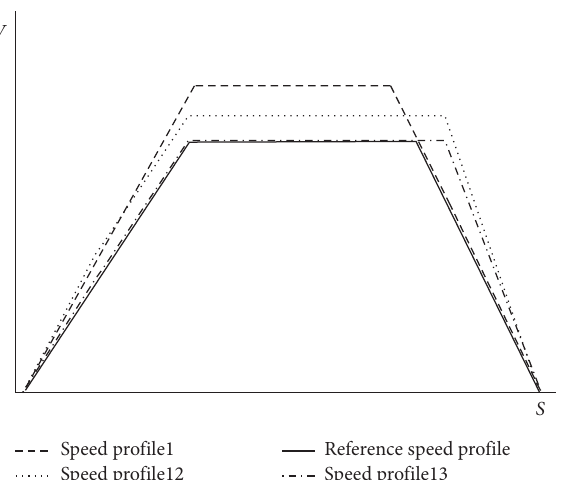
Figure 2: The schematic diagram of reference speed profile. The reference speed profile is a combination of multiple speed